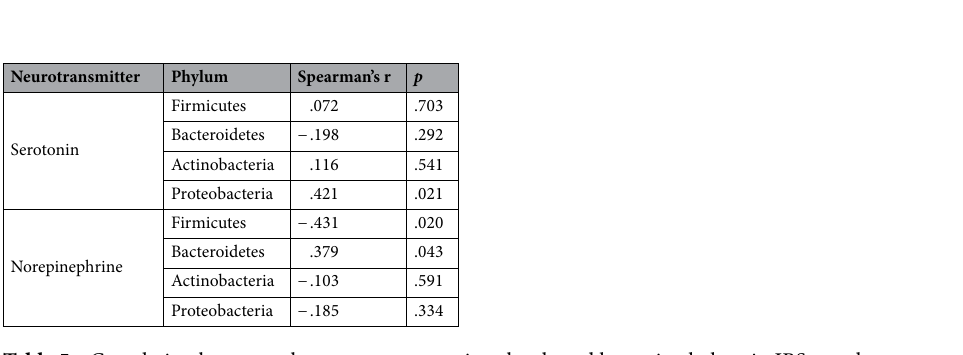
Table 5. Correlation between plasma neurotransmitter levels and bacteria phylum in IBS people.